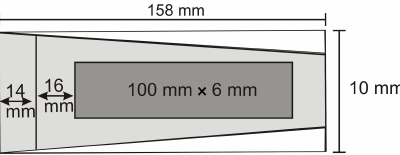
Figure 4. A two-dimensional cartoon of the HOLODEC sample volume (not to scale). The leftmost vertical line in the figure in- dicates the hologram plane. The light grey region indicates areas of maximum sensor sensitivity (the slope of the angled lines mark- ing the edge of the light grey region has been greatly magnified for aid in visualization). The vertical lines 14 and 158mm from the left edge of the figure mark the positions of the optical win- dows; near these windows there is evidence of artificially generated particles due to instrument-induced particle fragmentation. The vol- ume simulated here corresponds to the darker central grey rectangle (parallelepiped in 3-D), where the instrument retains approximately uniform sensitivity, particle locations and sizes are believed to be accurate, and the number of small particles generated due to frag- mentation on the instrument is believed to be